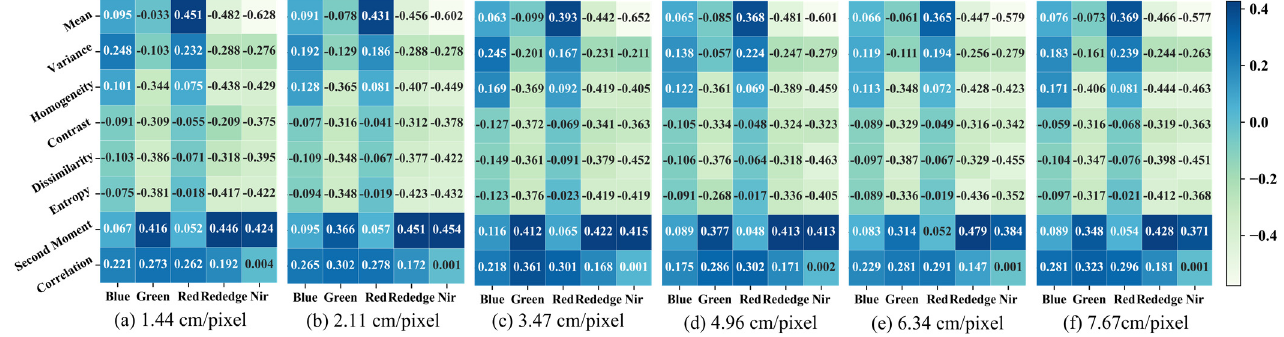
Figure 4. Correlation between images with different spatial resolutions and texture features. The abscissa represents the name of each band. The vertical coordinate represents the name of each texture feature. The data in the figure represent the correlation coefficients obtained from the correlation analysis of different bands and different texture features.